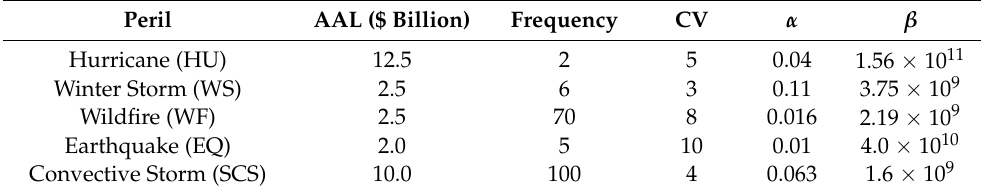
Table 1. This table contains the assumed parameters for the individual peril frequency and severity distributions that are used to form the multi-peril catastrophe model studied in this paper. Column 1 provides the peril names. Column 2 provides the average annual loss (AAL) for each peril against a hypothetical industry portfolio. Column 3 provides the average annual frequency of loss causing events per peril. Column 4 provides the coefficient of variation for each perils’ respective severity distribution. Columns 5 and 6 give the α and β parameters of the gamma distribution used to model the severity distribution for each peril. The multi-peril model is formed using a mixture of the various peril frequency and severity distributions as described in the main